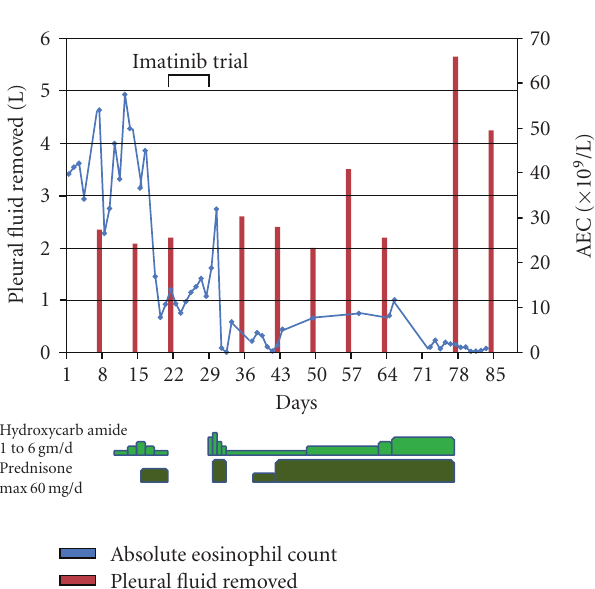
Figure 2: The e ff ect of treatment on the absolute eosinophil count (AEC) in peripheral blood. Eosinophilia normalizes with hydroxycarbamide plus prednisone. Total pleural fluid removed each week was unaltered by treatment adequate to normalize peripheral eosinophil